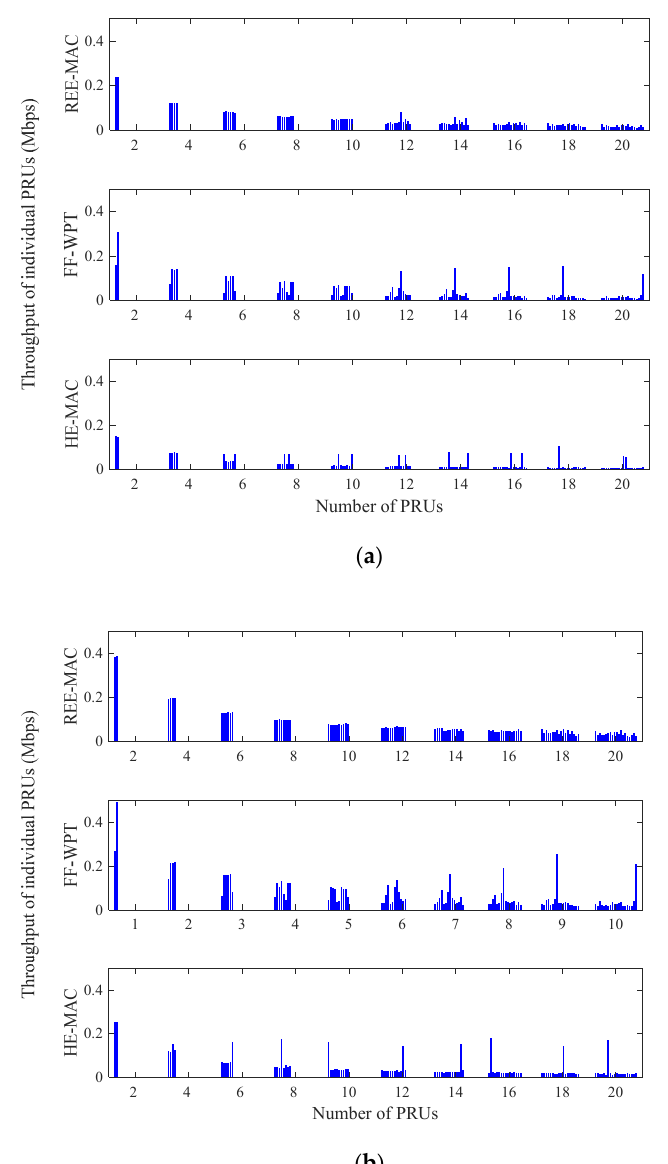
Figure 9. Throughput distribution of individual PRUs: ( a ) packet size of 100 bytes; ( b ) packet size of 200 bytes.